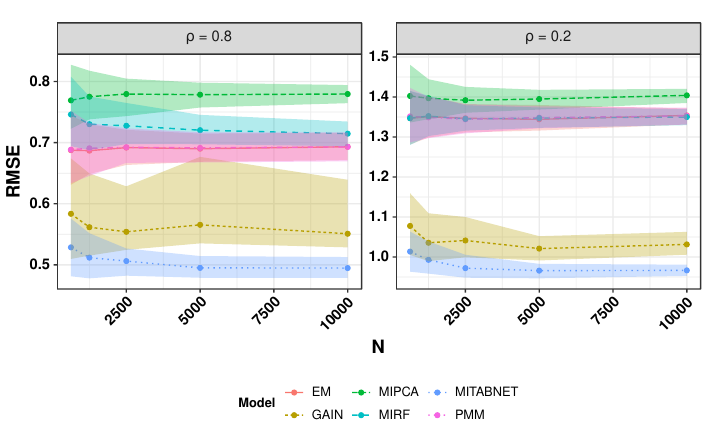
Figure 6. Head-to-head comparison of imputation algorithms in post-imputation accuracy in high and low correlation scenario and increasing sample